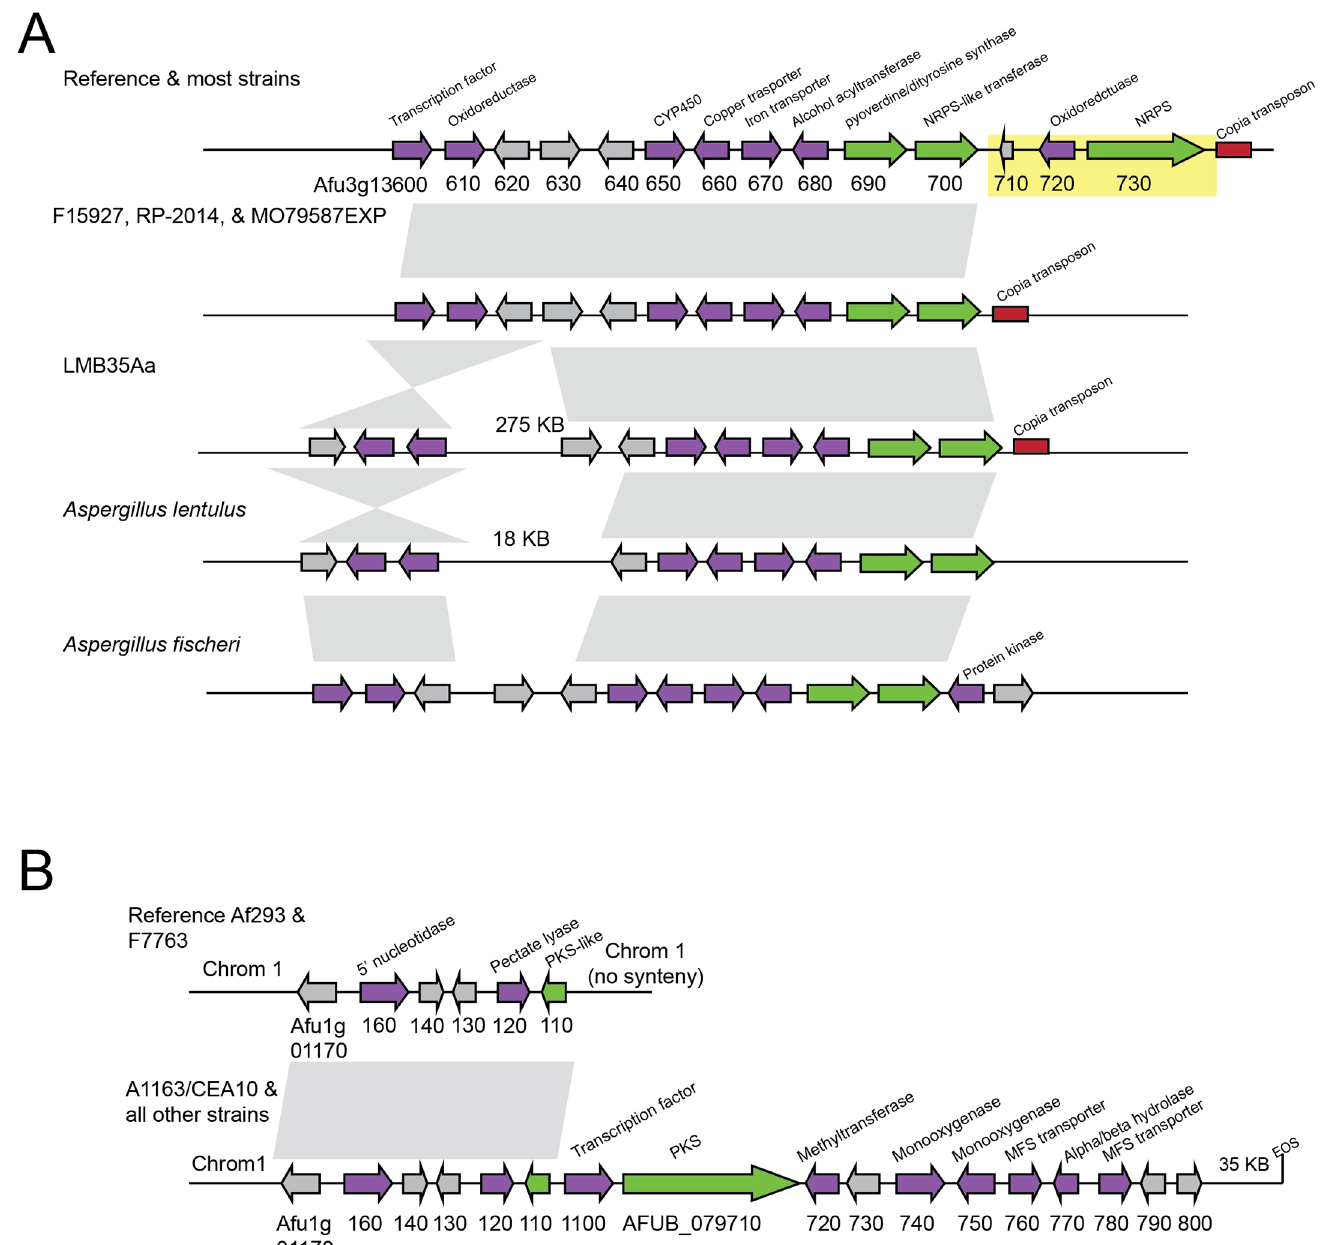
Fig 2. Gene gains and deletions in SM gene clusters. (A) Differencesin gene content in SM gene cluster 14 in Aspergillus fumigatus strains and closely related species. Four A . fumigatus strains lack an 11-kb regionin this cluster, including an NRPS backbonegene, highlightedin yellow. Regions upstream and downstreamof this cluster are syntenic. LMB35Aa also containsa large inversionthat moves a transcription factor, oxidoreductase, and hypothetical protein 275 kb away from the cluster. A . fischeri and A . lentulus ,close relativesof A . fumigatus , containa cluster lacking the 11-kb region. (B) SM gene cluster found in most A . fumigatus strains but absent from the Af293 reference and from the F7763 strain. EOS, end of scaffold; MFS, major facilitator superfamily; NRPS, nonribosomal peptidesynthase; SM, secondary